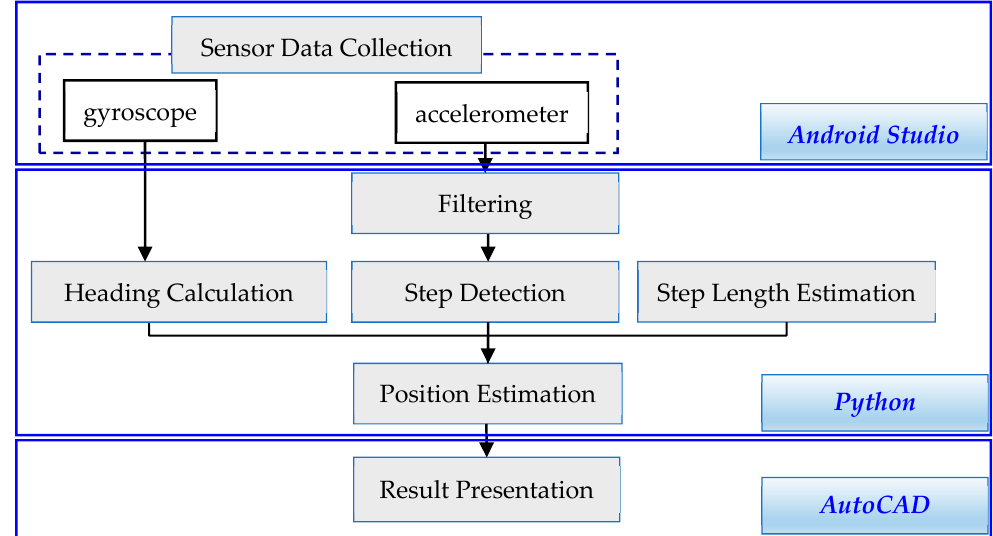
Figure 1. Pedestrian dead reckoning (PDR) structure.